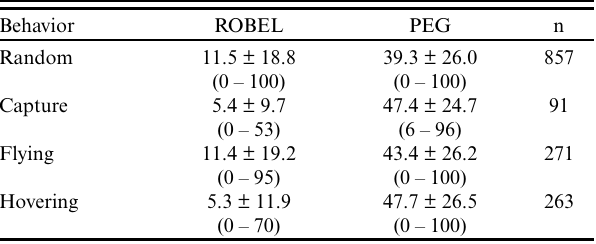
Table 5 . Mean ± 1 standard deviation for ROBEL and percent exposed ground (PEG) for each behavior class. Numbers in brackets are the